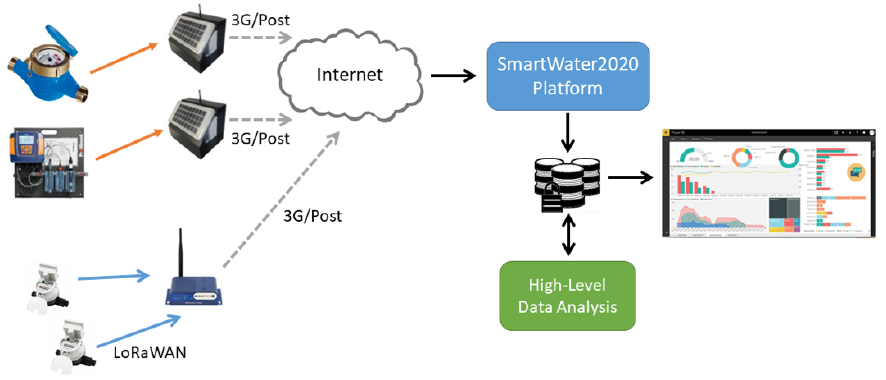
Figure 1. The SmartWater2020